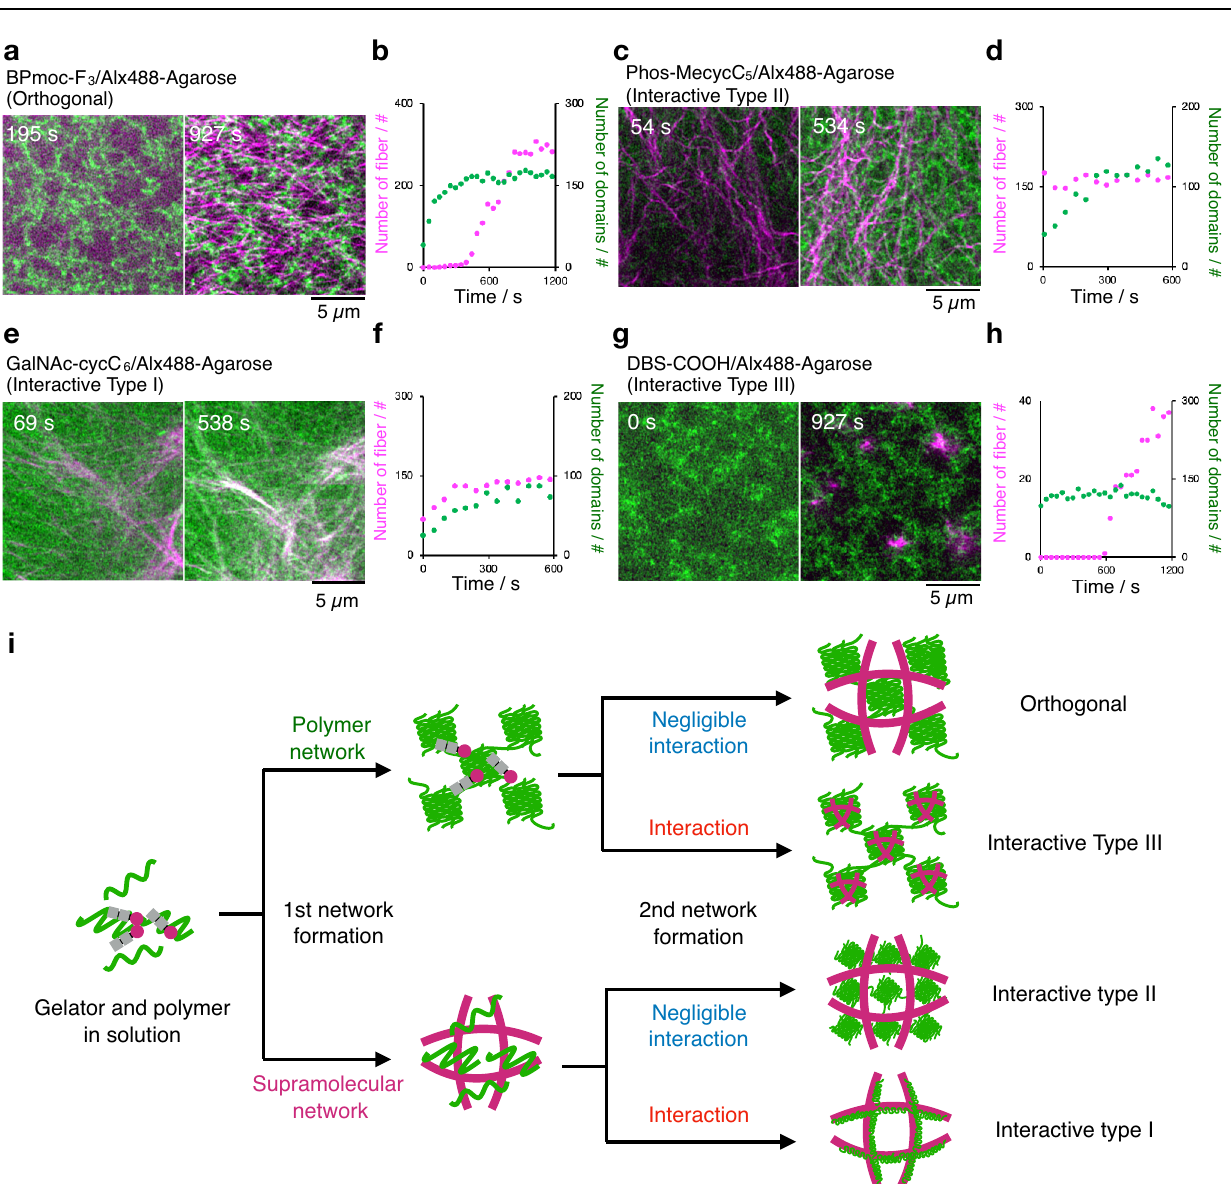
of the aggregated agarose domain. i Proposed mechanism of the network pattern formation. Conditions: [BPmoc-F 3 ]=0.1wt% (1.6mM), [Phos-MecycC 5 ]=0.4wt% (6.5mM), [GalNAc-cycC 6 ]=0.3wt% (4.6mM), [Alx488-Agarose]=0.5wt%, [TMR- Gua]=14 µ M,[Alx546-cycC 6 ]=4.0 µ M,[DBS-COOH]=0.2wt%(4.49mM),[glucono- δ -lactone]=44.9mM (for g , h ), solvent: 100mM MES pH 7.0 (for a – f ) or water (for g , h ),